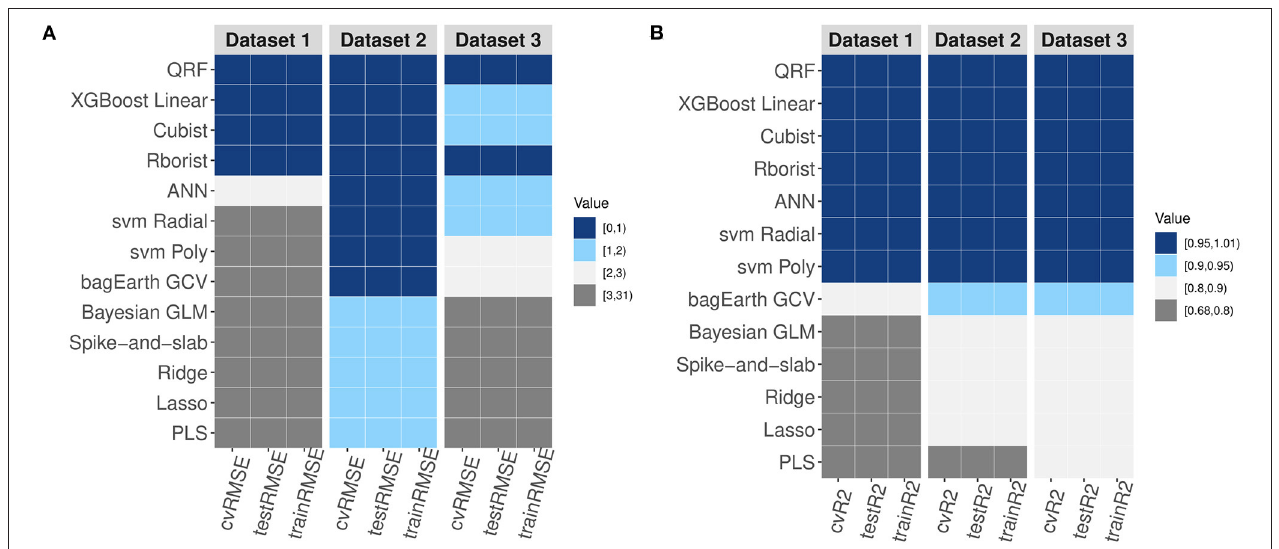
FIGURE 9 | Comparison of the RMSE and R 2 of the three datasets. (A,B) Variation of RMSE (A) and R 2 (B) values for the different models and for each dataset.